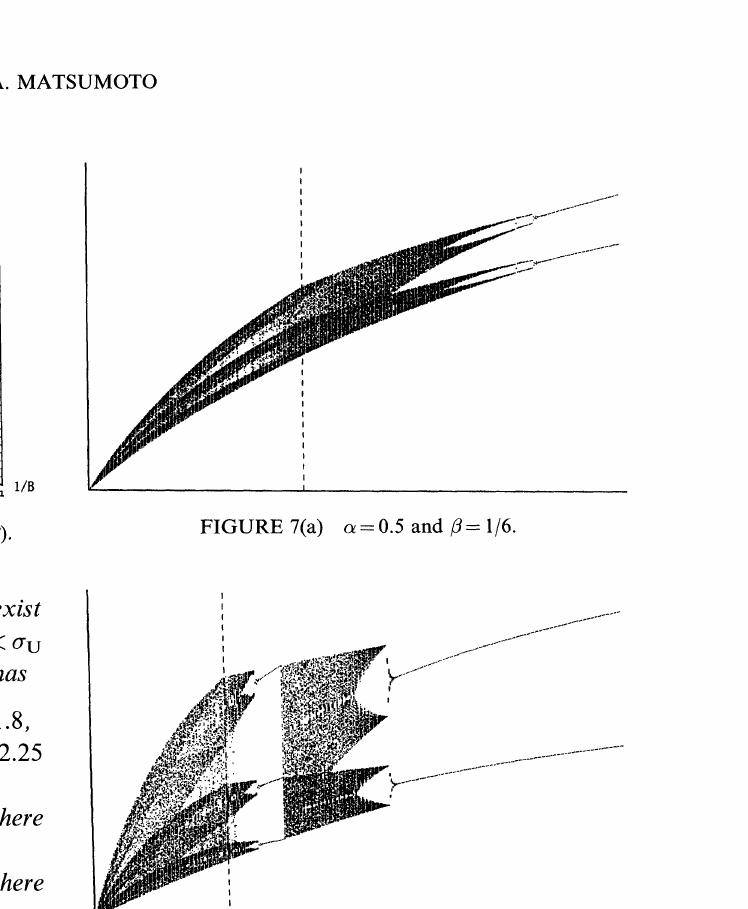
FIGURE 6 Regime classification of parameters (A,B).